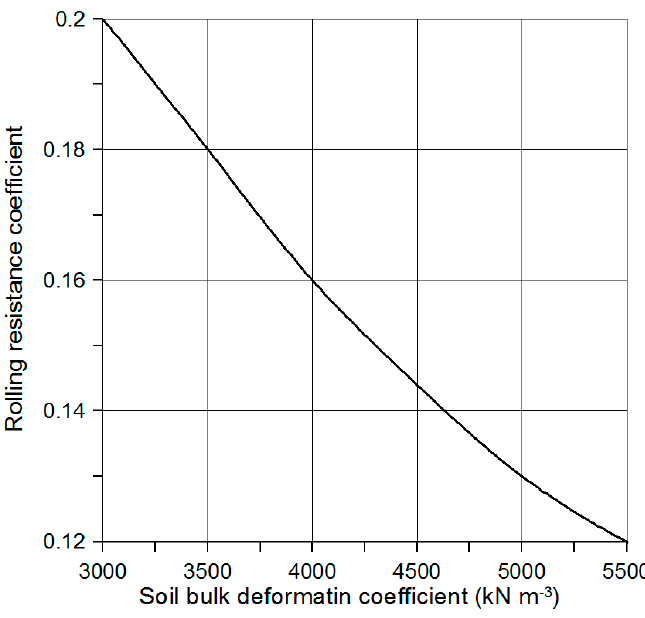
Figure 6. Dependence between coefficients (cid:1863) (cid:3042) and (cid:1858) (cid:3038) Really, the value of the coefficient (cid:1863) (cid:3042) , as is well known, is larger for density (solidity) soil. In this case, it had less value of the coefficient (cid:1858) (cid:3038) [7]. Practically, this means that an increase/decrease in the rolling resistance coefficient’s value is compensated by a corresponding decrease/increase in the value of the soil bulk deformation coefficient. As a result, the value of the maximum slip (cid:2012) (cid:3040)(cid:3028)(cid:3051) is determined only by the accepted values (but not variations) of the coefficients mentioned above and by the value of the ratio (6).